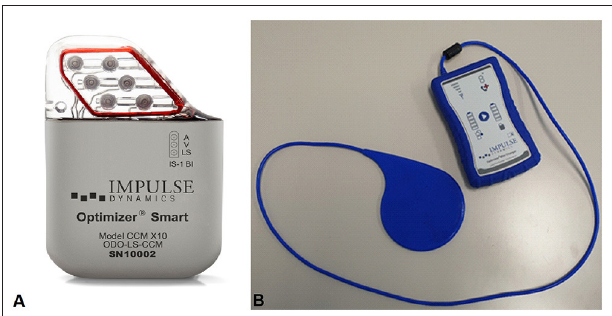
FIGURE 1 | Optimizer Smart ® system. (A) The Optimizer Smart ® Implantable Pulse Generator (IPG) unit. (B) Optimizer Smart Charger System. Patients can recharge the IPG unit using a portable, home-based charger system, without supervision. Charging the device on a weekly basis assures it has enough energy to provide the prescribed dose of CCM